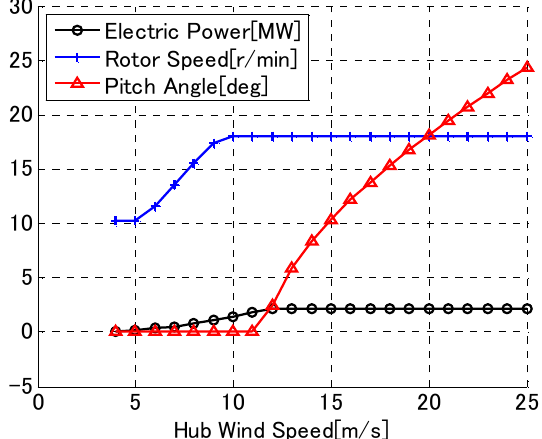
Fig. 3 Power, Rotor Speed, and Pitch Angle to Steady Wind Speed